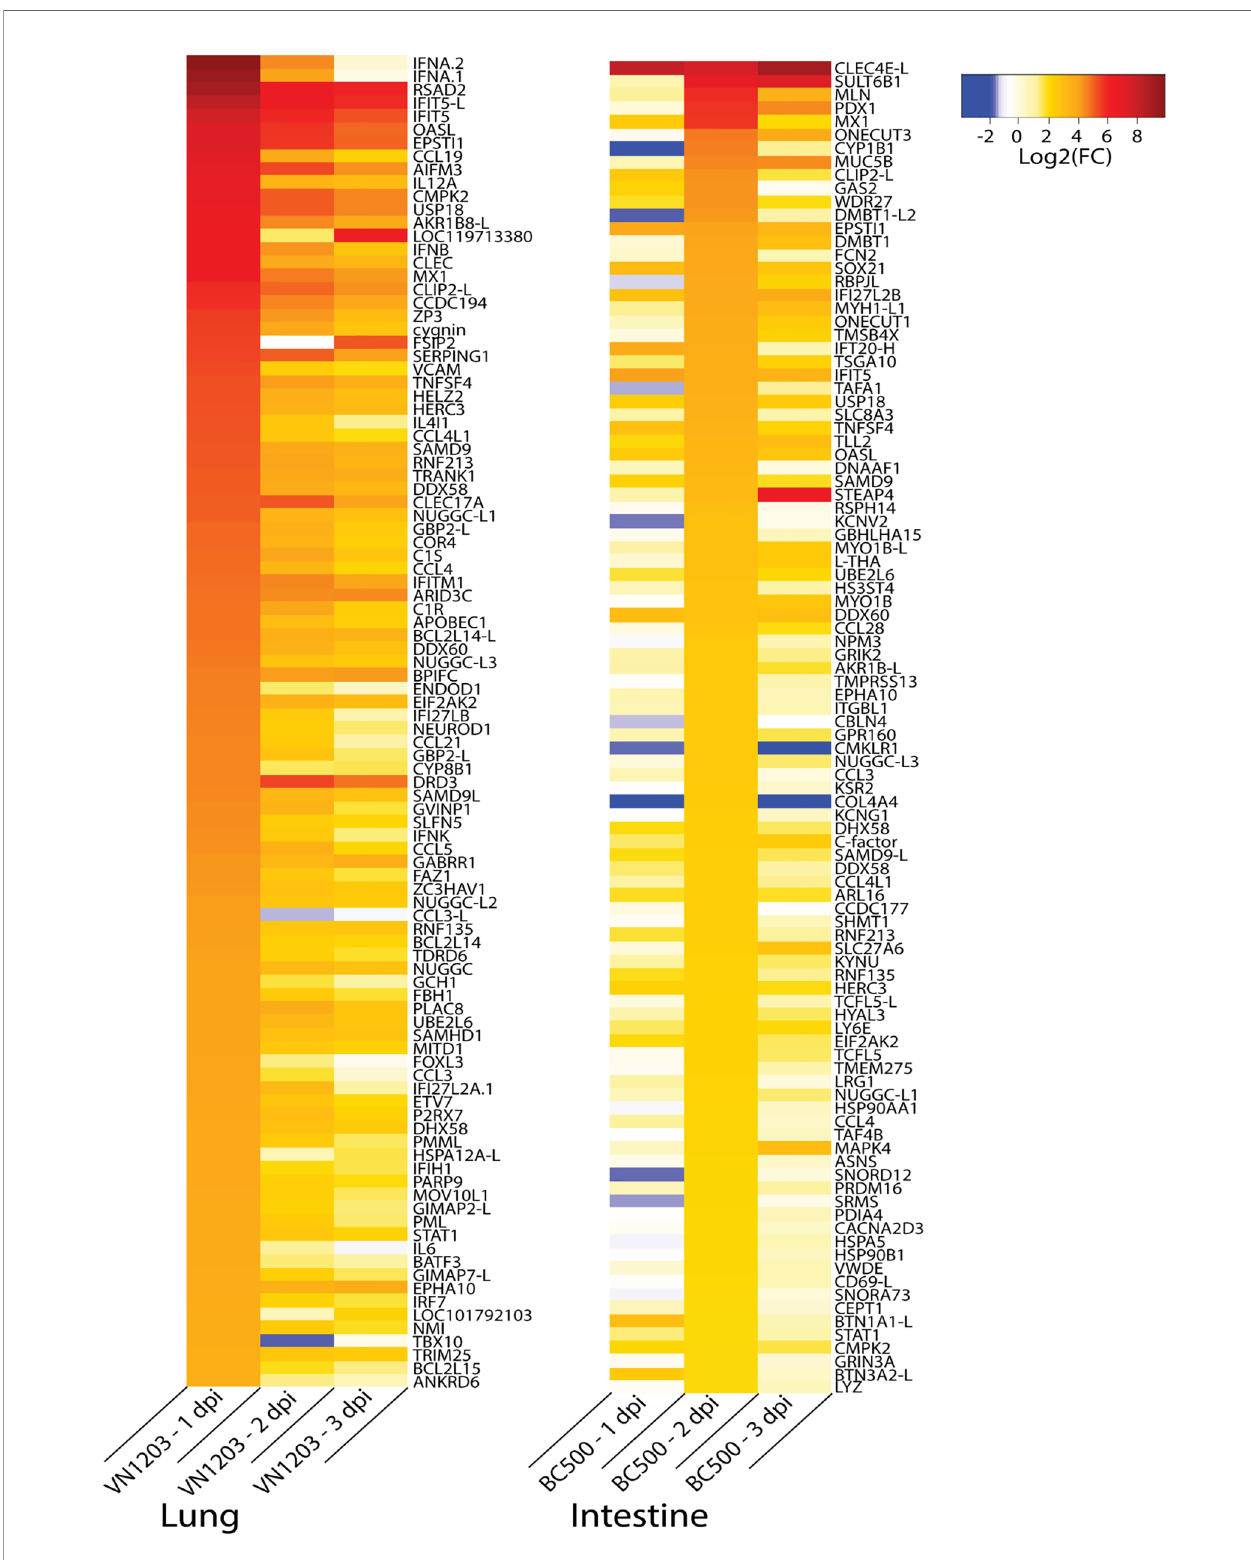
FIGURE 7 | Top 100 upregulated genes in lungs of VN1203 and intestines of BC500 infected ducks. Lists of statistically signi fi cant (FDR<0.05) genes were fi ltered for the top 100 genes expressed in lungs of VN1203 infected ducks on 1 dpi, and intestines of BC500 infected ducks on 2 dpi. Redundant genes, pseudo genes and genes denoted as ncRNA in NCBI were manually removed from